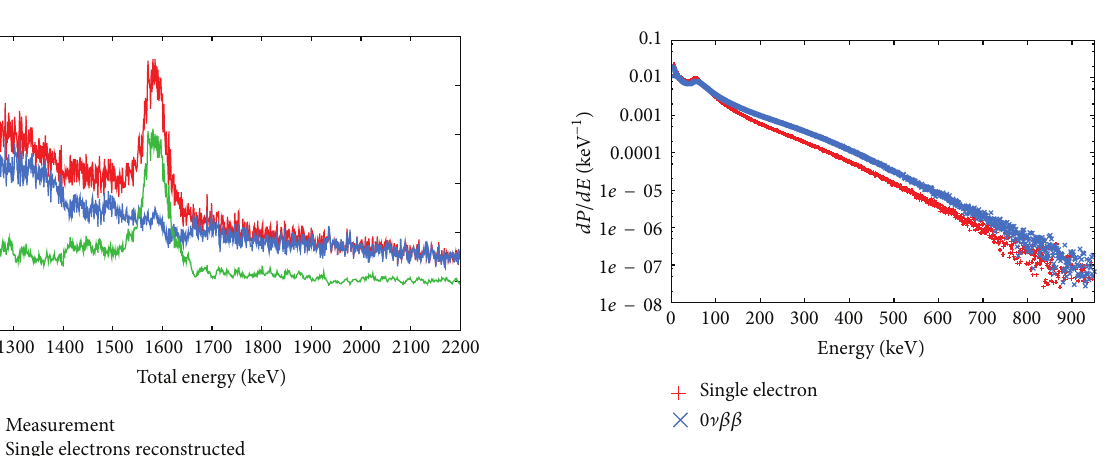
Figure 5: Probability density 𝑑𝑃/𝑑𝐸 that a triggered pixel in a track has collected a certain energy 𝐸 for neutrinoless double-beta decay (blue) and for single electrons (red). 2.8 MeV total deposited energy in the track was required for both event